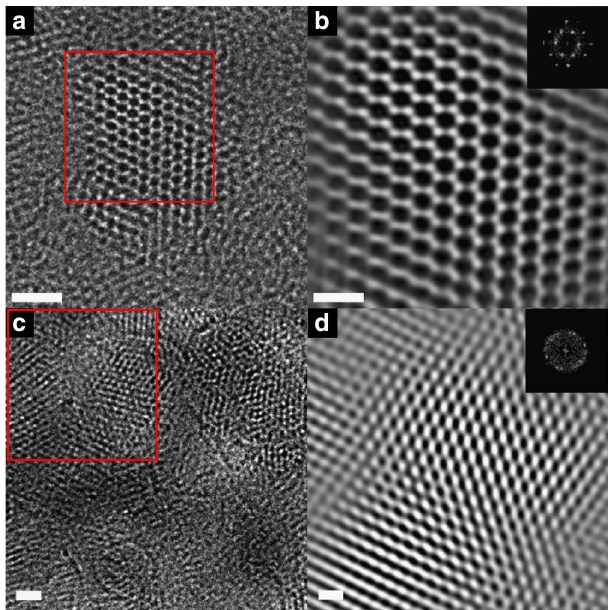
Fig. 3 HRTEM characterization of COF-1 and MF-1a. a Low-dose, high- resolution TEM image of COF-1 (scale bar, 10 nm). b The Fourier- fi ltered image of selected red square areas (scale bar, 5 nm), Inset: Fast Fourier Transform (FFT) from the red square on the COF-1. c Low-dose, high- resolution TEM image of MF-1a (scale bar, 10 nm). d The Fourier- fi ltered image of the selected red square area (scale bar, 5 nm), Inset: FFT from the red square on the MF-1a